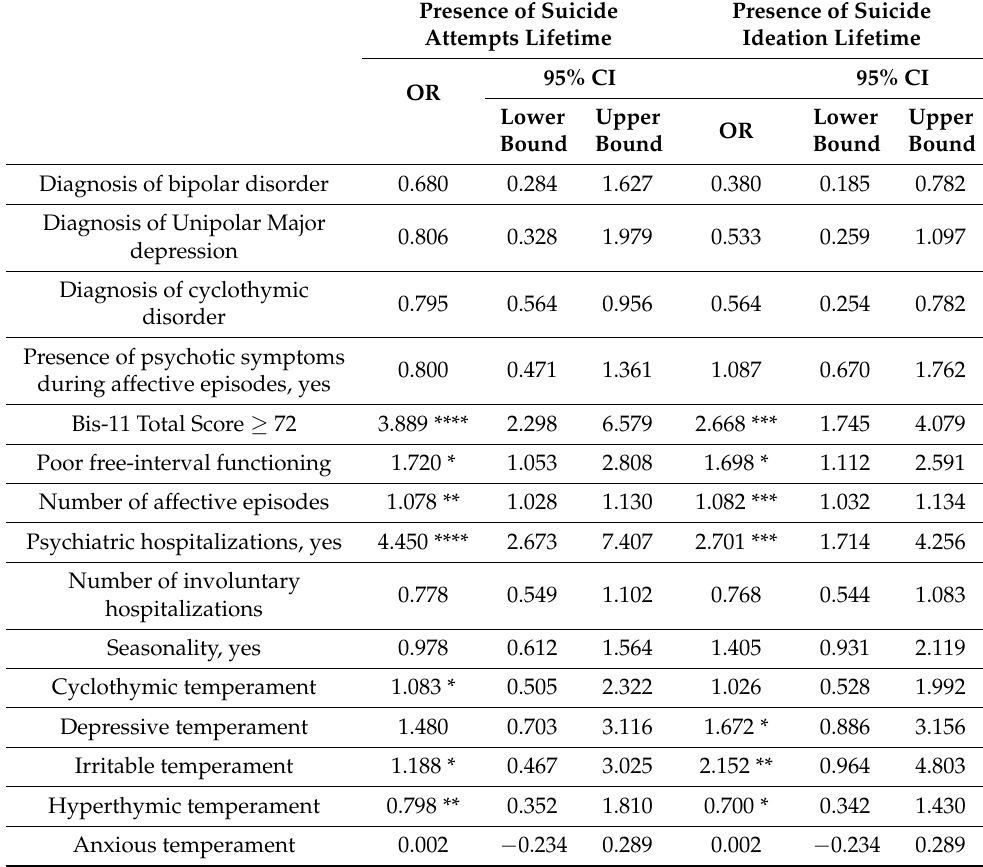
Table 2. Logistic regression analyses.